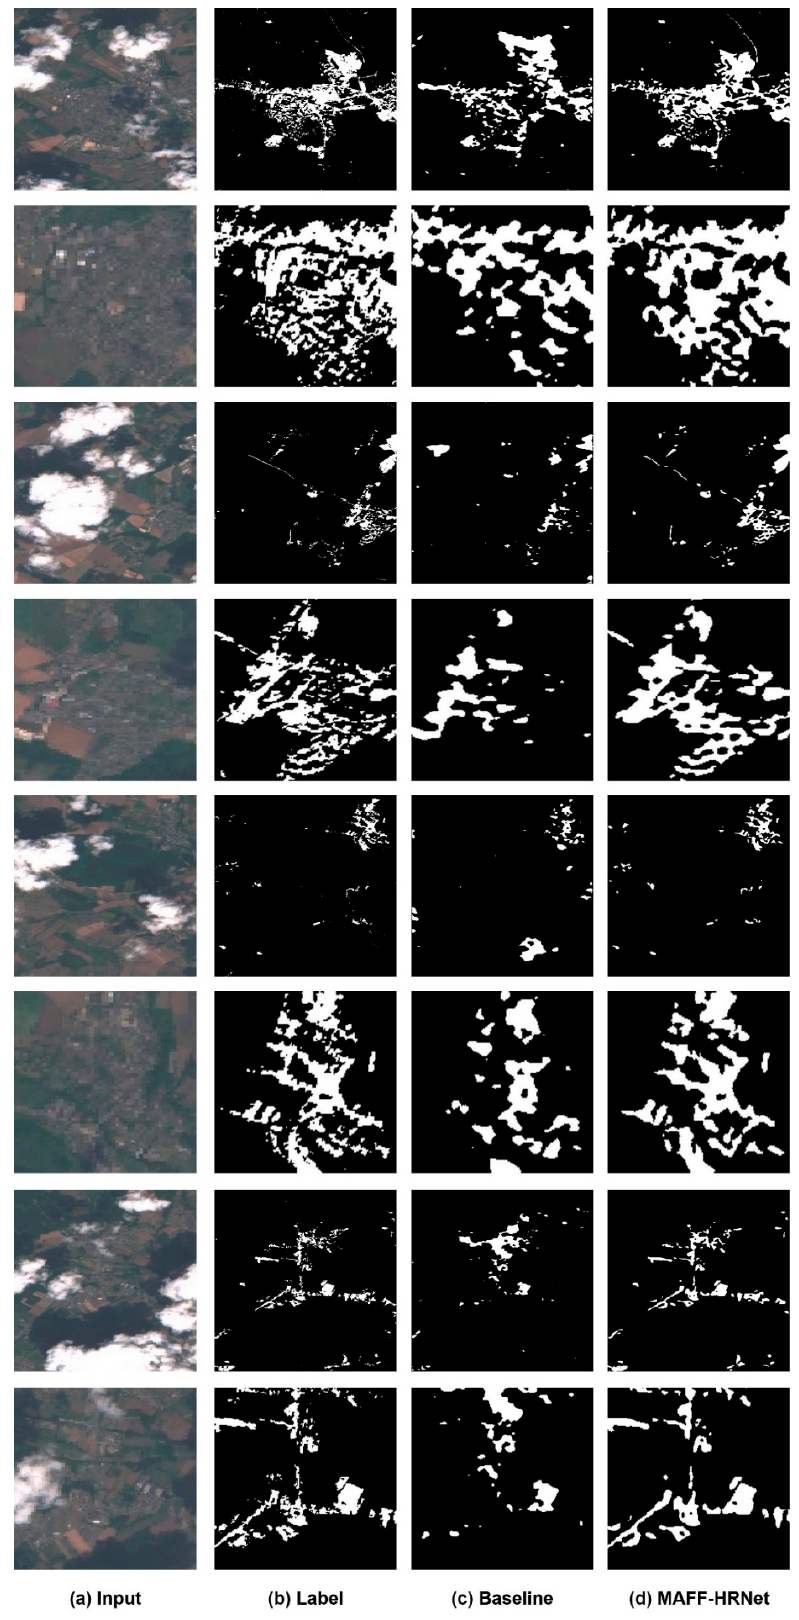
Figure 10. Experimental results on the World-Cover Dataset. ( a ) Original images. ( b ) Image labels. ( c ) Results of the baseline model. ( d ) Results of our model.